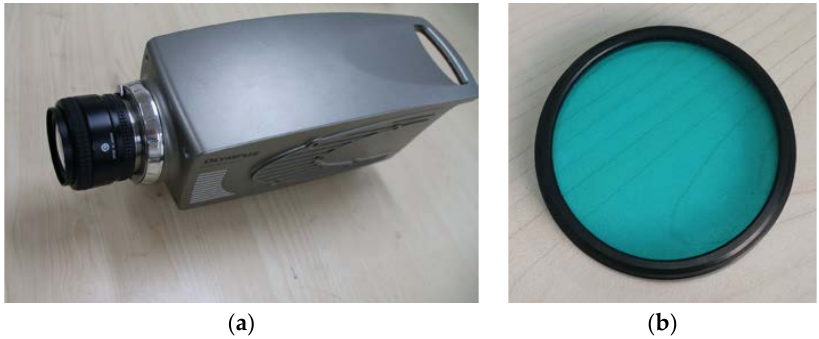
Figure 3. Flame measuring instruments: ( a ) high-speed camera; ( b ) optical filter.